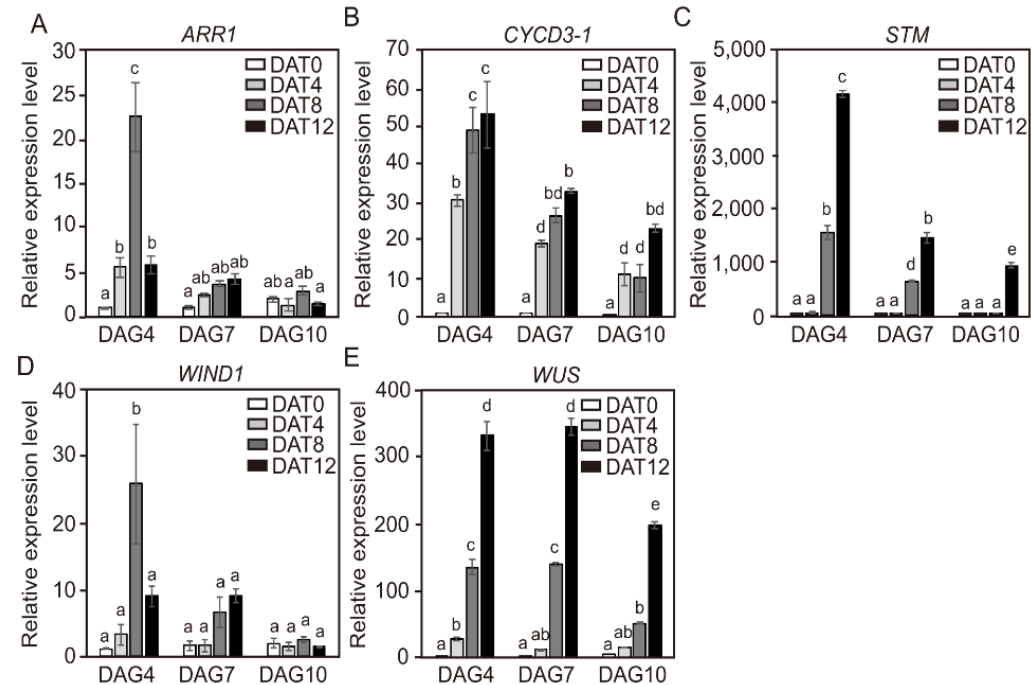
Figure 5. The relative expression levels of CYCD3-1 and shoot regeneration regulatory genes in the cotyledon explants at di ff erent ages for tomato seedlings during incubation in shoot induction medium (SIM). The relative gene-expression level of ARR1 ( A ), CYCD3-1 ( B ) , STM ( C ), WIND1 ( D ), and WUS ( E ) in the proximal position of cotyledon explants of DAG4, DAG7, and DAG10 seedlings. Data are representative of the results from three independent experiments Error bars represent SD (n = 3). Di ff erent letters on the bars indicate significant di ff erences between each treatment (ANOVA followed by a Turkey’s test, p < 0.05). DAG = day after germination; DAT = day after treatment. Positional di ff erences in the expression of the CYCD3-1 and four shoot-regeneration regulatory genes in the three segments of cotyledons derived from 4-day-old seedlings were also examined (Figure 6B). The transcript levels of all five genes were highest in the proximal segments (Figure 6B). These gene-expression profiling results did not perfectly match the shoot formation results from the three cotyledon segments (Figure 3D). Thus, the transcript levels of the five genes from each of the DAG4 cotyledon segments were also examined at 4-day intervals after being transferred to SIM for shoot formation (Figure 8). The transcripts levels of all five genes gradually increased in the proximal segments as the incubation time in SIM was extended. Similar to the hypocotyl explants, the transcript levels of three genes ( CYCD3-1 , STM , and WUS ) from the cotyledon explants slightly declined from the proximal to the central to the distal segments. The other two genes ( ARR1 and WIND1 ) were highly expressed in the proximal segments of the cotyledon explants, whereas there was no significant di ff erence in expression levels between the central and the distal